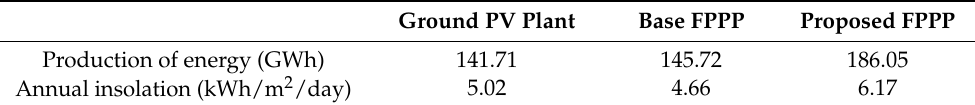
Table 4. Comparison of Ground PV, Base FPPP and Proposed